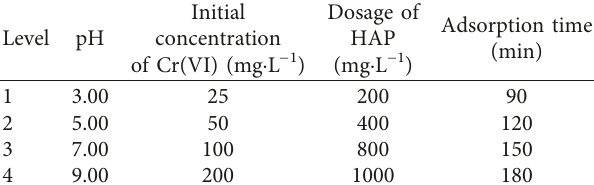
Table 1: Levels and factors of orthogonal experiment design.